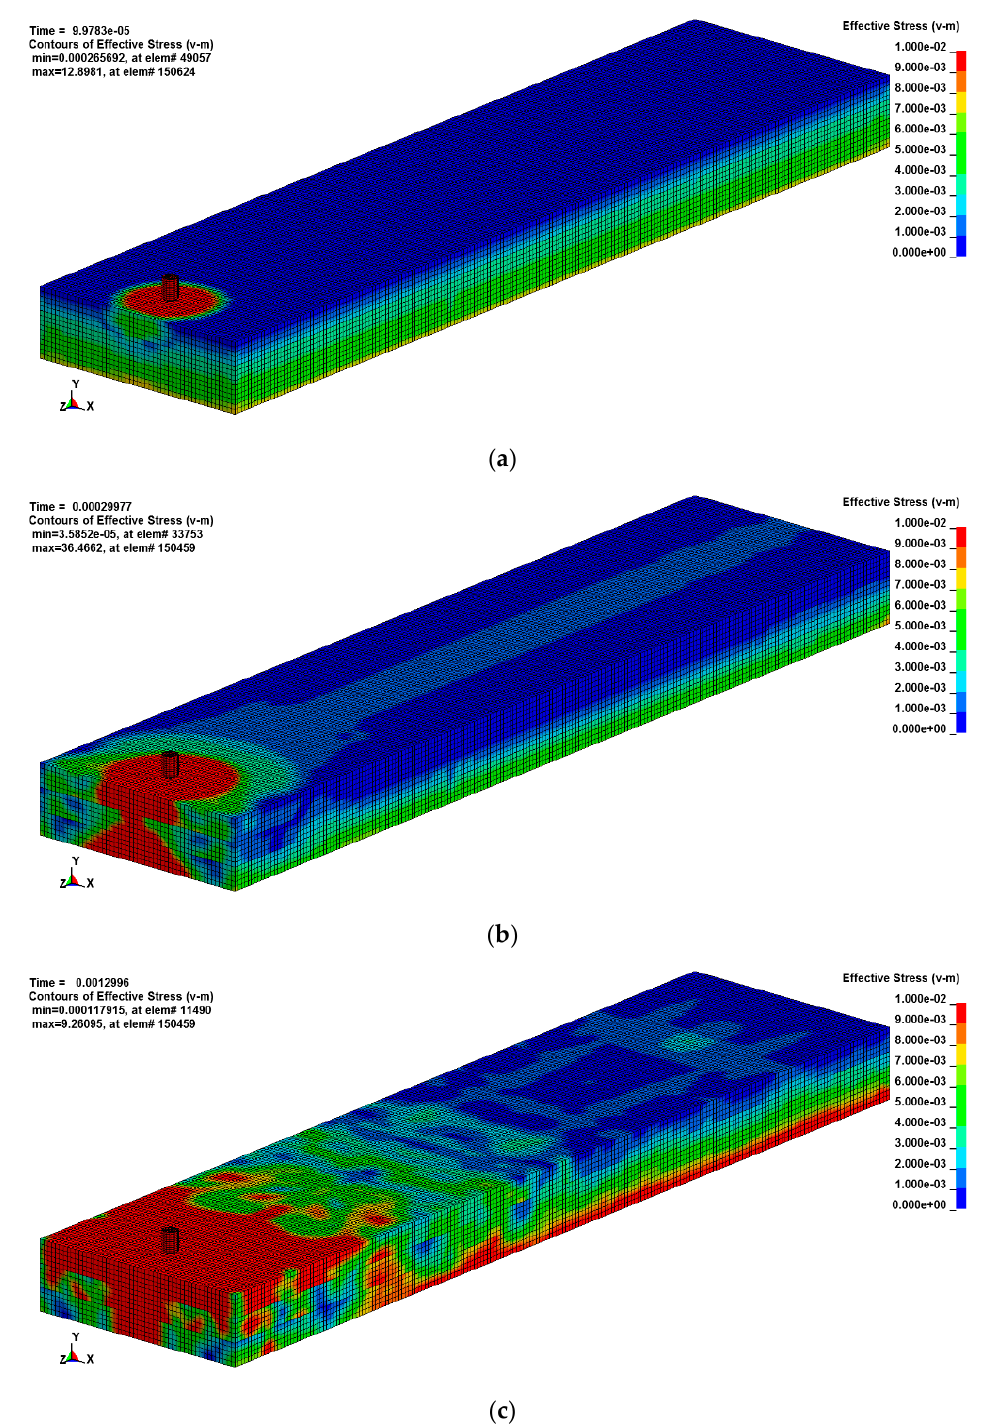
Figure 2. The stress cloud diagram at different moments: ( a ) t = 9.983× 10 − 2 ms; ( b ) t = 2.9977× 10 − 2 ms; ( c ) t = 1.2996 ms.